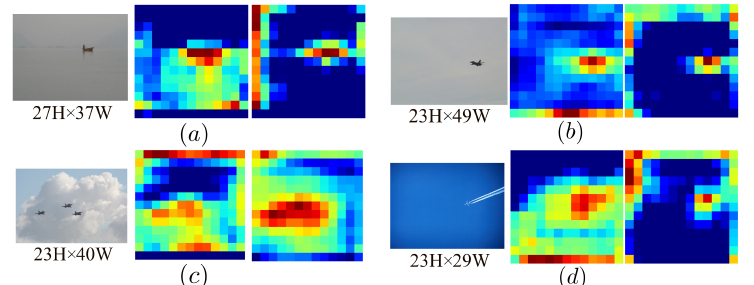
Figure 13. The comparison of SPP output and CFM output using heatmaps. The left image in each group represents the original sample, the middle image is the original frame’s SPP output, and the right image is the CFM result. The object size in the photograph is indicated by the mark beneath